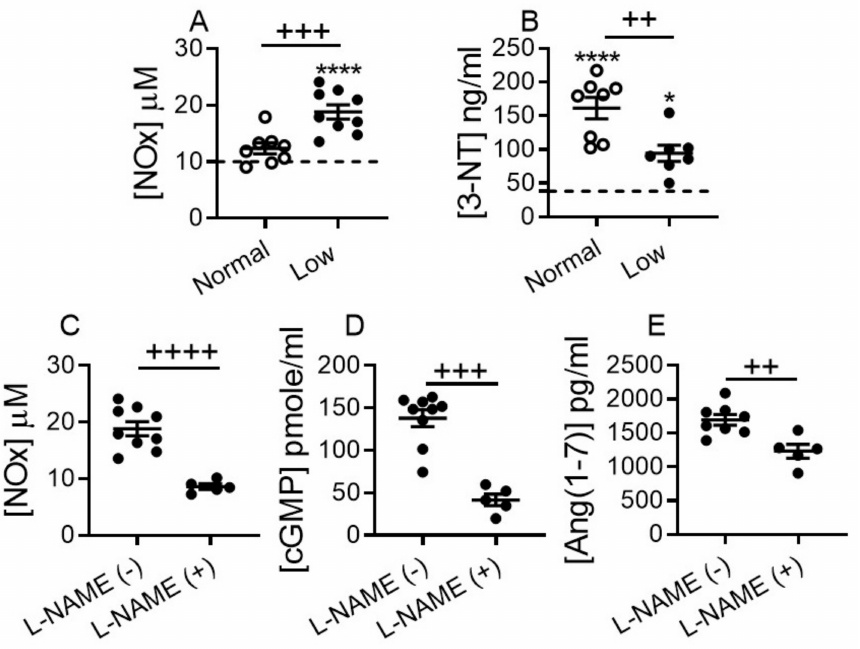
Figure 7. Low-sodium diet increases the nitric oxide (NO) plasma levels in mice with DCM. ( A ) Total nitrite (NO 2 − ) and nitrate (NO 3 − ) plasma levels (NOx = NO 2 − + NO 3 − ). ( B ) 3-nitrotyrosine levels, (3-NT). DCM mice on NSD n = 8, on LSD n = 7–9 per group. ( C – E ) Suppression of plasma levels of ( C ) total nitrite/nitrate, ( D ) cGMP and, ( E ) Ang (1–7) by short-term L-NAME (N-nitro-L-arginine methyl ester) tail vein infusion. Number of DCM mice L-NAME( − ) n = 8–9 per group; L-NAME(+) n = 5 per group. WT control mice (dashed line, n = 8). Data are presented as mean ± SEM, **** p < 0.0001, * p < 0.05 (DCM vs. WT), and ++++ p < 0.0001, +++ p < 0.001, ++ p < 0.01 (DCM on LSD vs. DCM on NSD). Data were analyzed by one-way ANOVA with Newman–Keuls multiple comparison